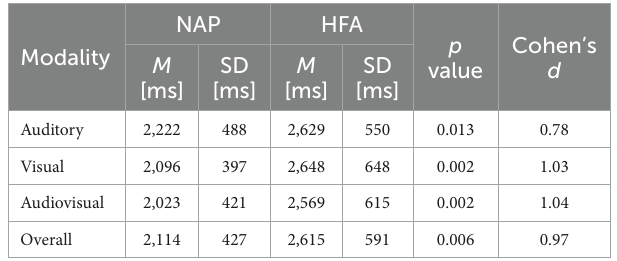
TABLE 3 Response times per